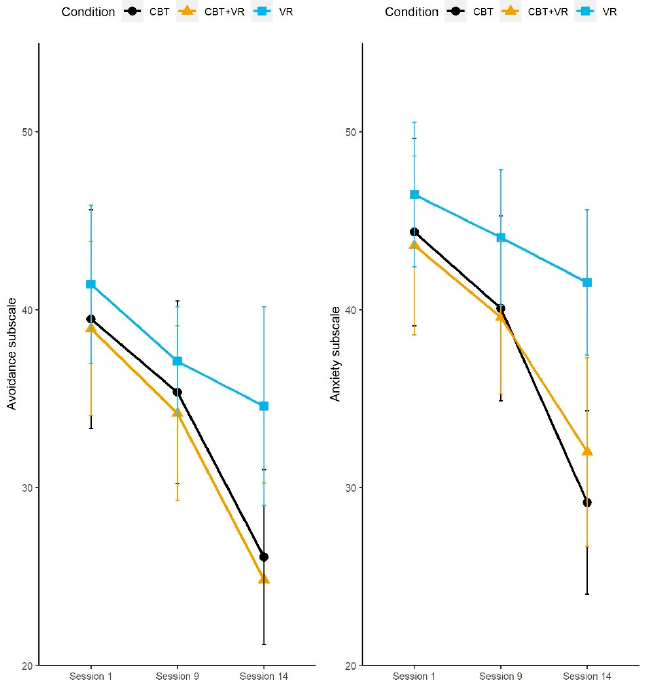
Figure 3. Anxiety and Avoidance subscales of Liebowitz Social Anxiety Scale scores split by condition and measurement time. Error bars represent 95% confidence intervals.